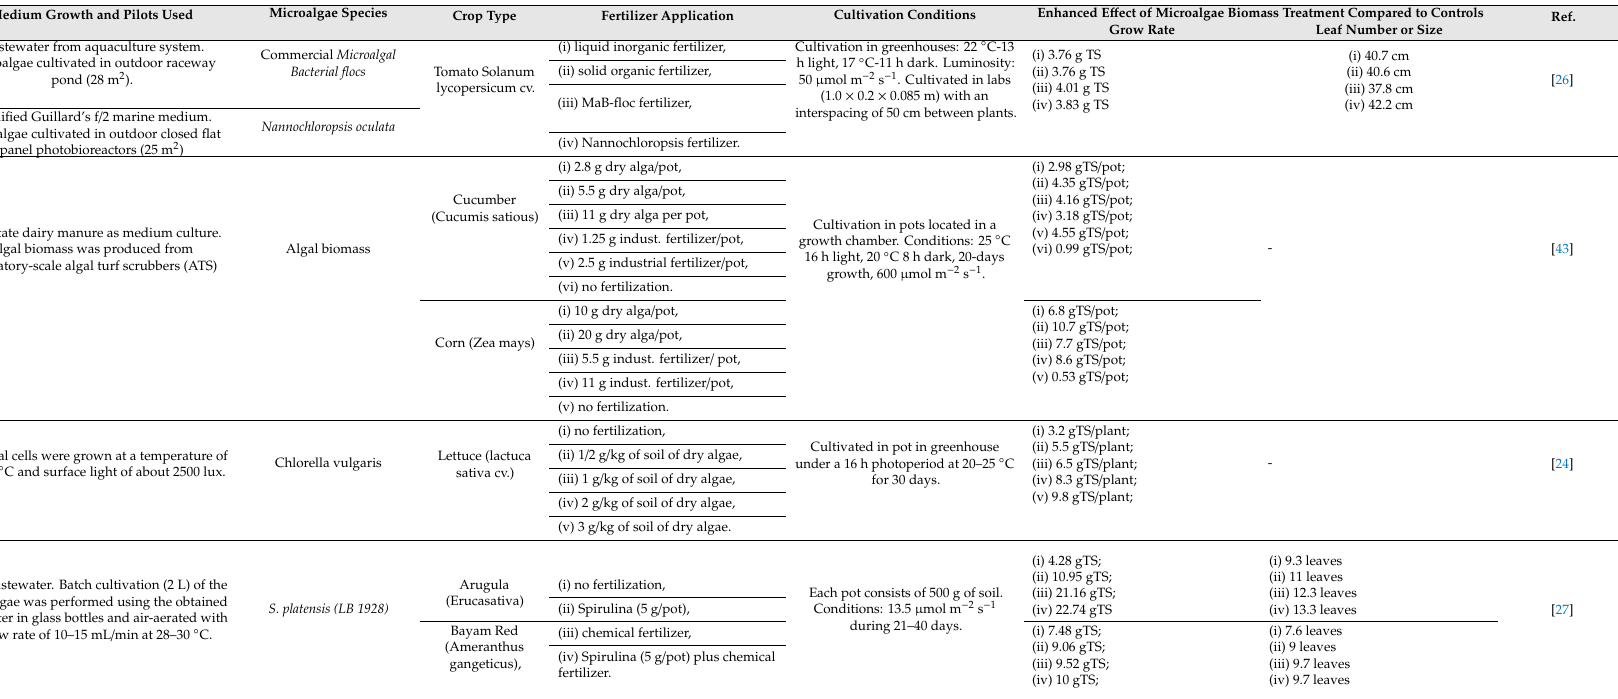
Table 5. Literature review of microalgae biomass used as fertilizers for plants